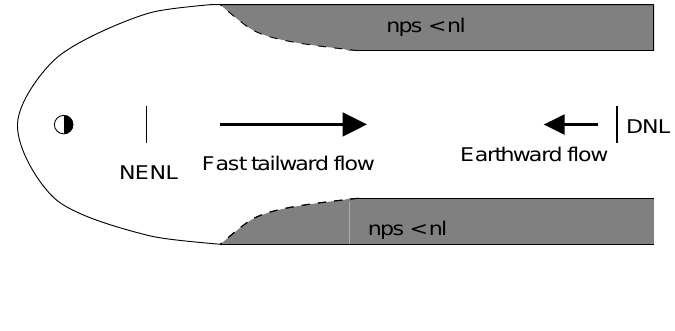
Fig. 2. Diagram of the magnetotail observed during geomagnetically active and quiet times. During active periods, reconnection takes place in the centre of the tail, earthward of 60 R E . Along the < n flanks of the magnetosphere, n , PS L as would be expected if reconnection is not taking place in the plasma sheet in this region and if the magnetopause is open in the lobe region. During quiet times, earthward flows are seen more often, and we note they tend to be seen earthward of 140 R E . Slow flows are seen across the tail. We find that 40% of the slow flows at the flanks could be driven by transfer of momentum across the magnetopause, by, for example, the Kelvin Helmholtz